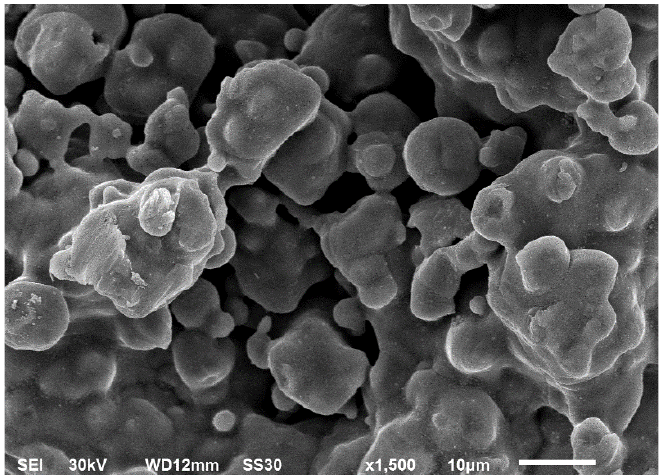
Figure 3. SEM micrograph of ZVI nanoparticles.